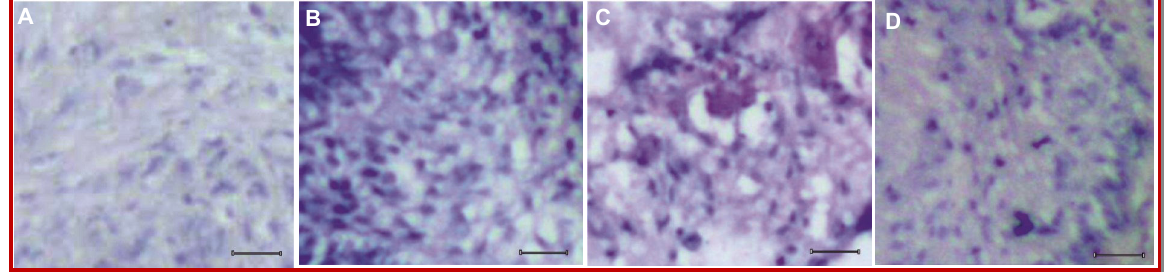
Figure 1: Transverse section of mice kidney. Normal mice kidney showing compact arrangement of cells ( A). Moderate damage of mice kidney following 0.75% adenine ingestion on day 2 (B). Histology of mice kidney developed acute kidney injury on day 4, which shows more disturbed tissue pattern (C). Rescue with P2X7 antagonist (D)